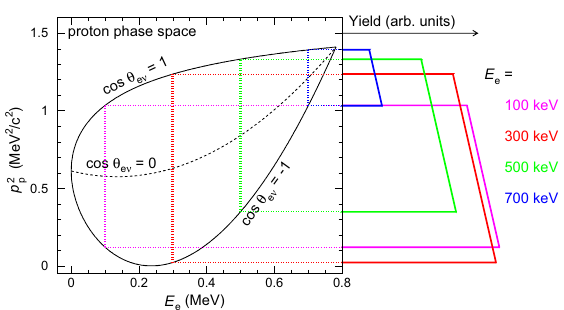
Figure 1. Plot of the phase space of cos( θ e ν ) as a function of p 2 and E e with projections of the squared proton momentum p ) for a fixed electron energy E e and an ideal distribution P ( p 2 p ∝ 1/ t 2 detection system of p 2 (denoted trapeziums in the text). p p since the neutrino energy can be related to the